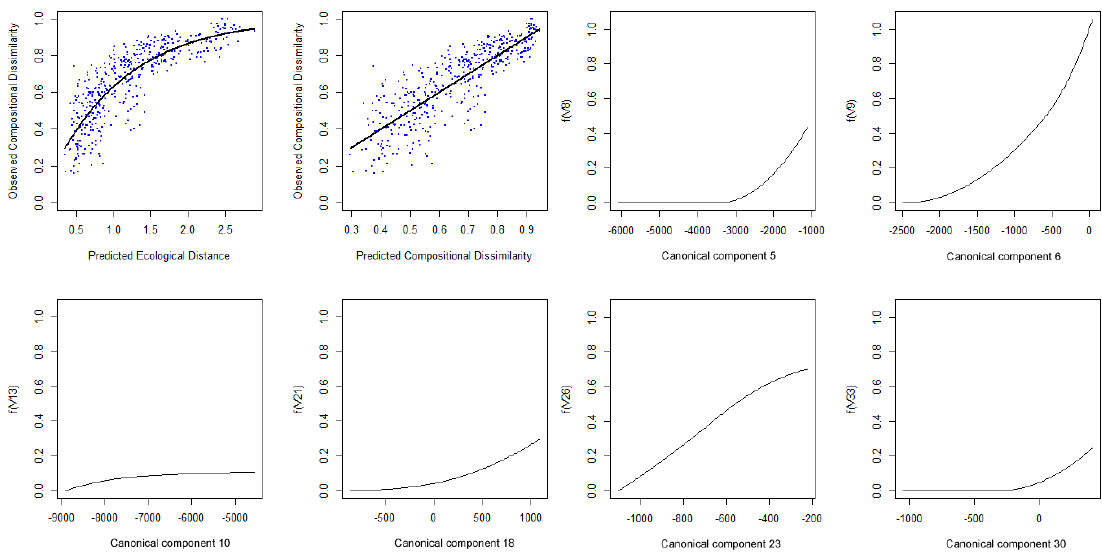
Figure 4. Plot of the fitted generalized dissimilarity modelling (GDM) model and respective I-splines.